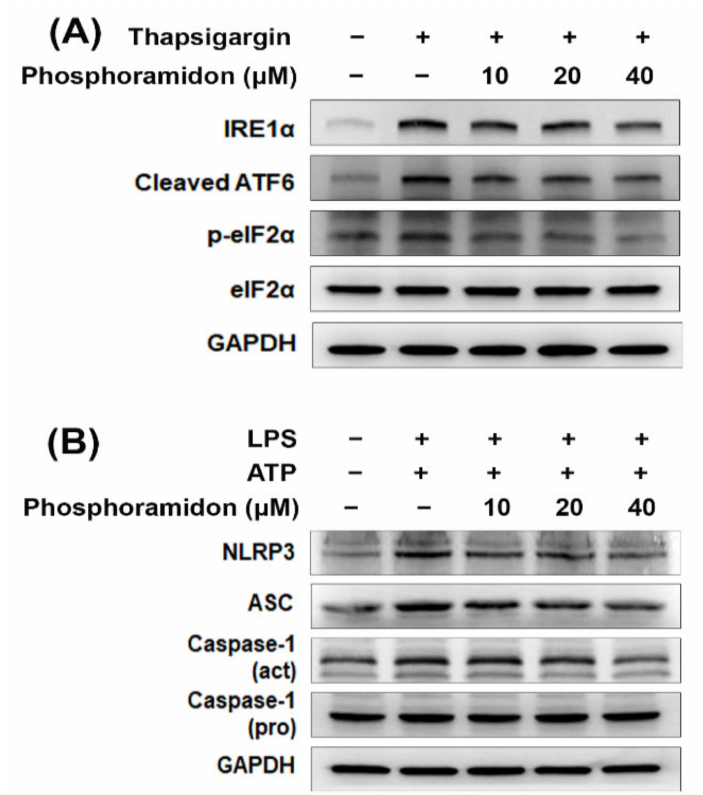
Figure 4. Phosphoramidon reduces ER stress and the NLRP3 inflammasome in HK-2 cells. ( A ) Western blot analysis of ER stress-related protein expression in HK-2 cells. Cells were pretreated with phos- phoramidon for 6 h and then treated with 150 nM thapsigargin for 18 h. ( B ) Western blot analysis of NLRP3 inflammasome-related protein expression in HK-2 cells. Cells were incubated for 24 h with phosphoramidon and 1 µ g/mL LPS and then treated with 2 mM ATP for 2